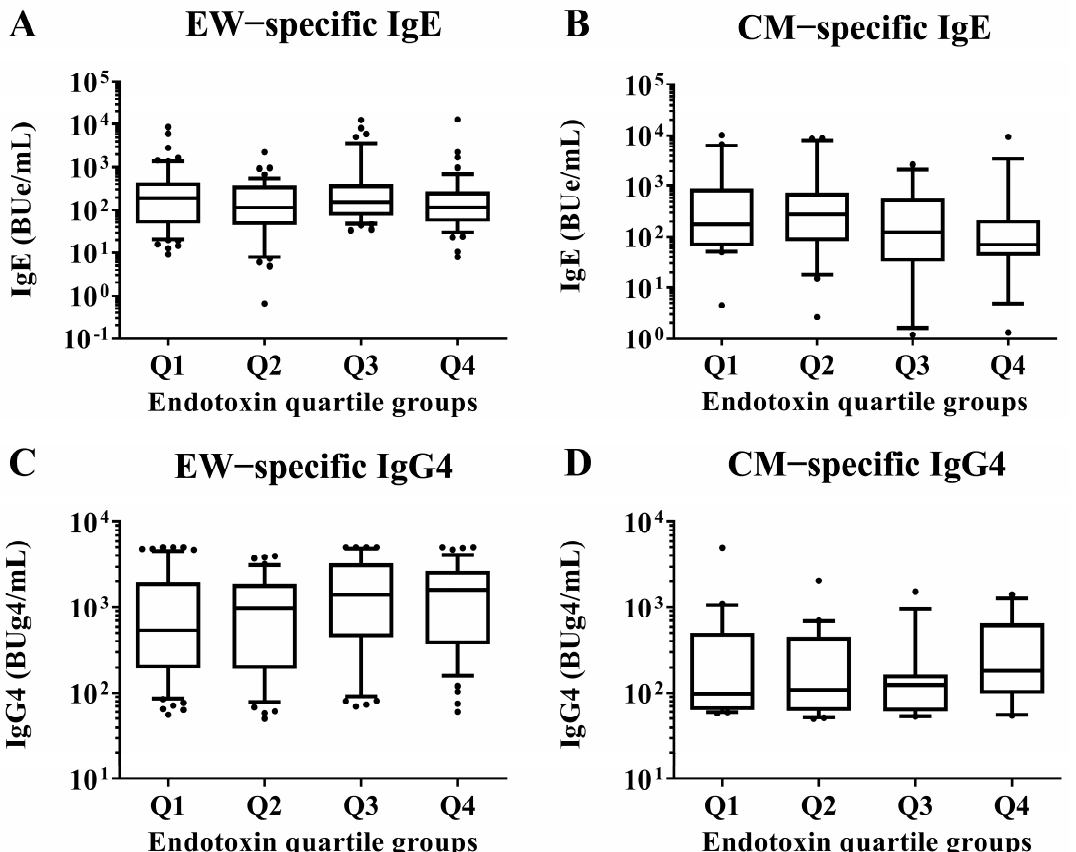
Figure 3. Comparisons of EW- and CM-specific IgE and IgG4 levels in sera of children aged 2 years according to the quartile groups of endotoxin concentration (Q1–Q4) per 1 mg of house dust collected from the mattresses of the children at 18 months old. These show results in ( A ) EW − specific IgE level, ( B ) CM − specific IgE level, ( C ) EW − specific IgG4 level and ( D ) CM − specific IgE level. p -values were calculated for each log-converted Ig level using Mann–Whitney U test based on Q1. p -values < 0.05 were considered significant. IgE, immunoglobulin E; IgG4, immunoglobulin